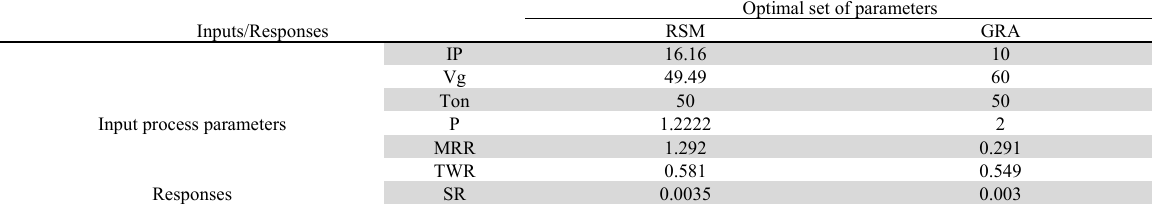
Experimental values, GRC and GRG of A356/WC